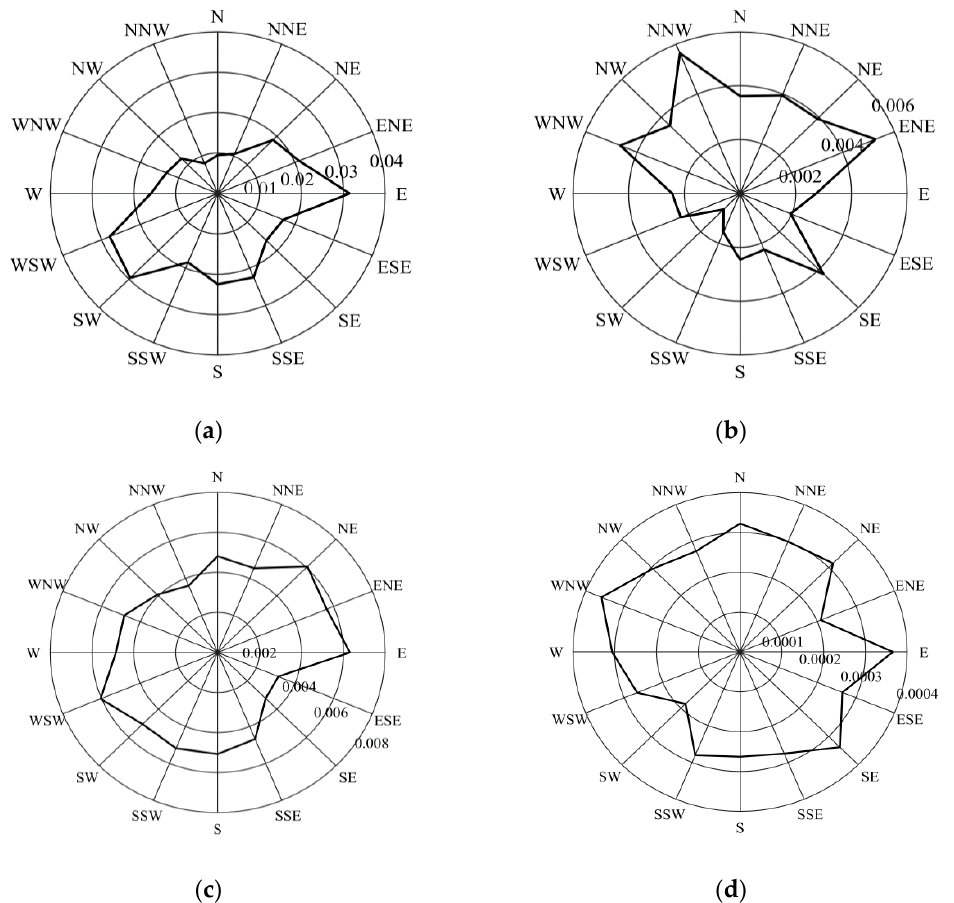
Figure 7. ( a ) Changes in z 0 m with different wind directions at Xiaotang from 5 January to 31 December 2010. ( b ) Same as ( a ) but for z 0 h . ( c ) Same as ( a ) but for a magnitude of 10 − 3 . ( d ) Same as ( b ) but for a magnitude of 10 − 4 .